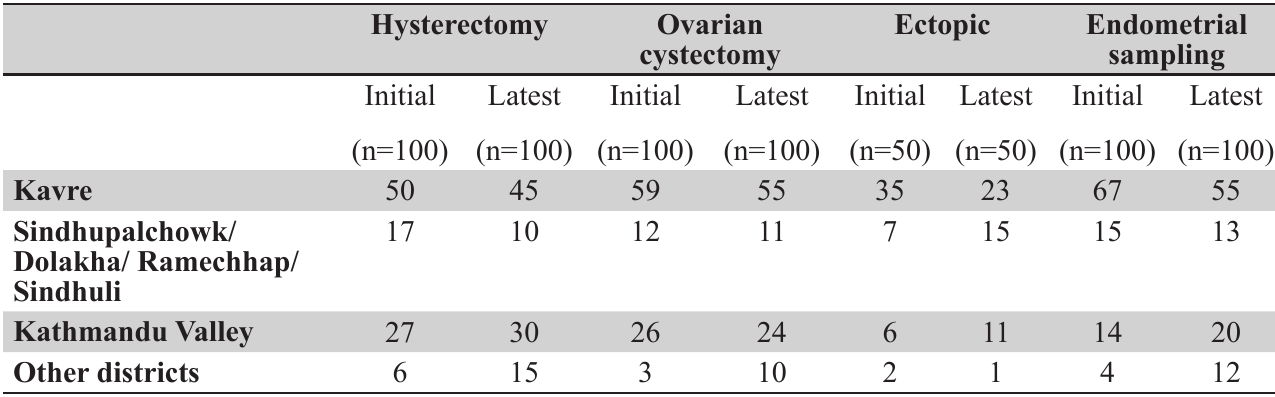
Table 2: Address of operated cases